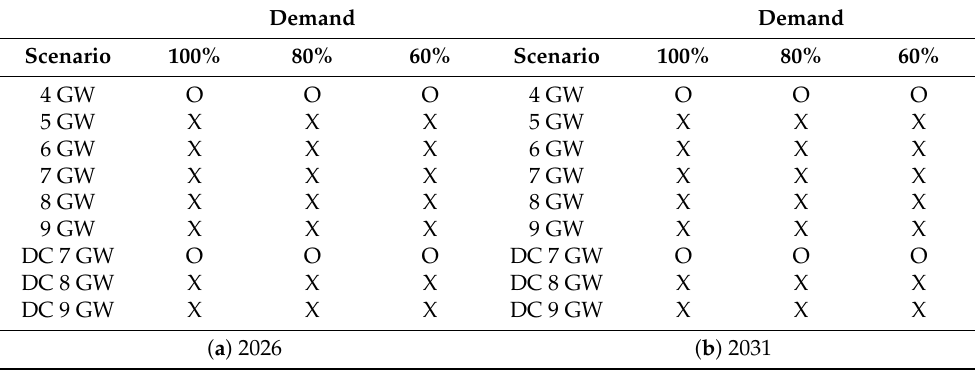
Table 12. Results for transient stability analysis after a clearing time of six cycles.